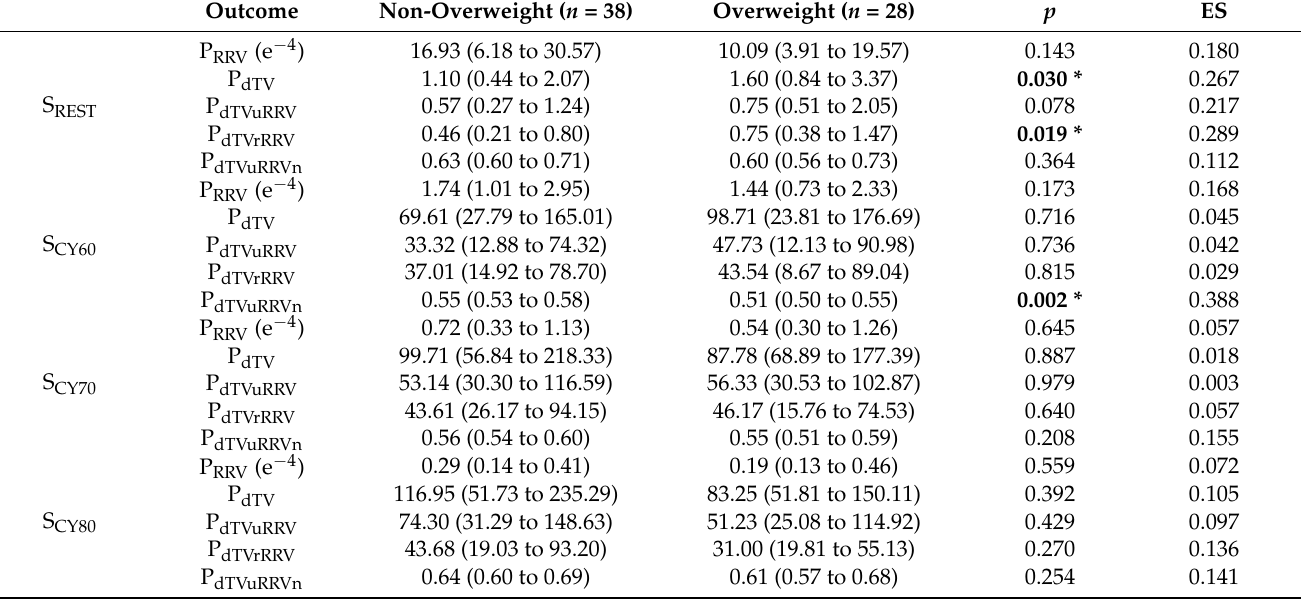
Table A2. Comparison of P RRV , P dTV , P dTVuRRV , P dTVrRRV and P dTVuRRVn between BMI